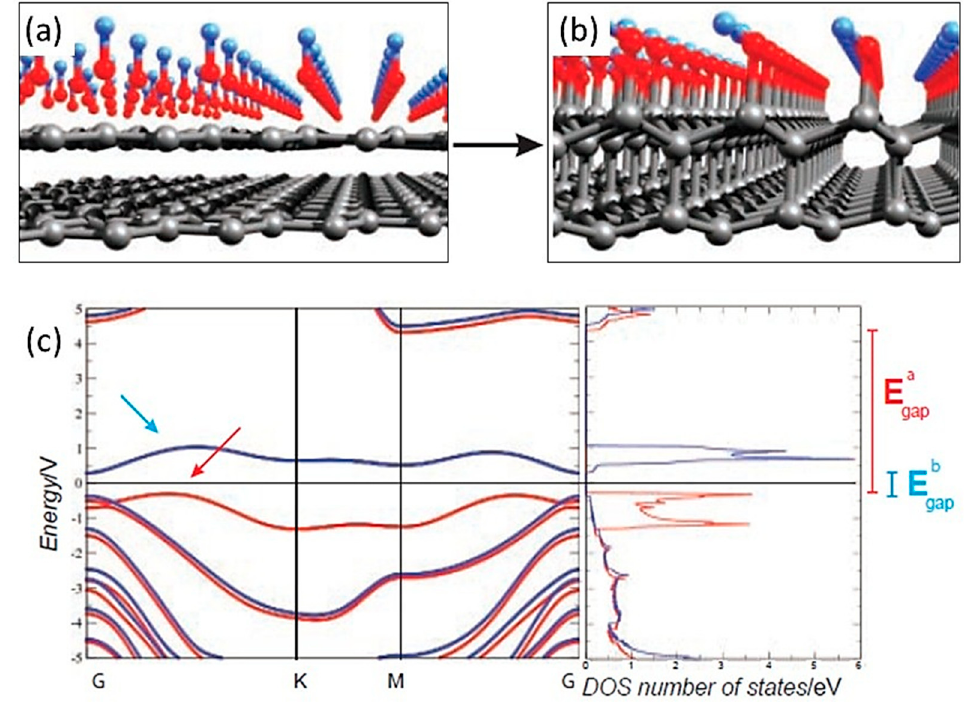
Figure 5. The initial structure with hydroxyl groups on bigraphene ( a ) and diamandol ( b ); the spin-dependent electronic dispersion of the bond spectrum ( c ) and the density of states (DOS) for the unit cell of the Don structure ( c ). The red and blue colors indicate spin-up and spin-down components, respectively [26].